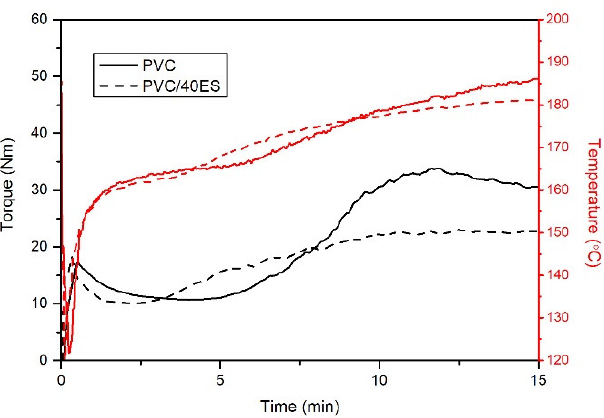
Figure 3. Particle size distribution of eggshell filler.